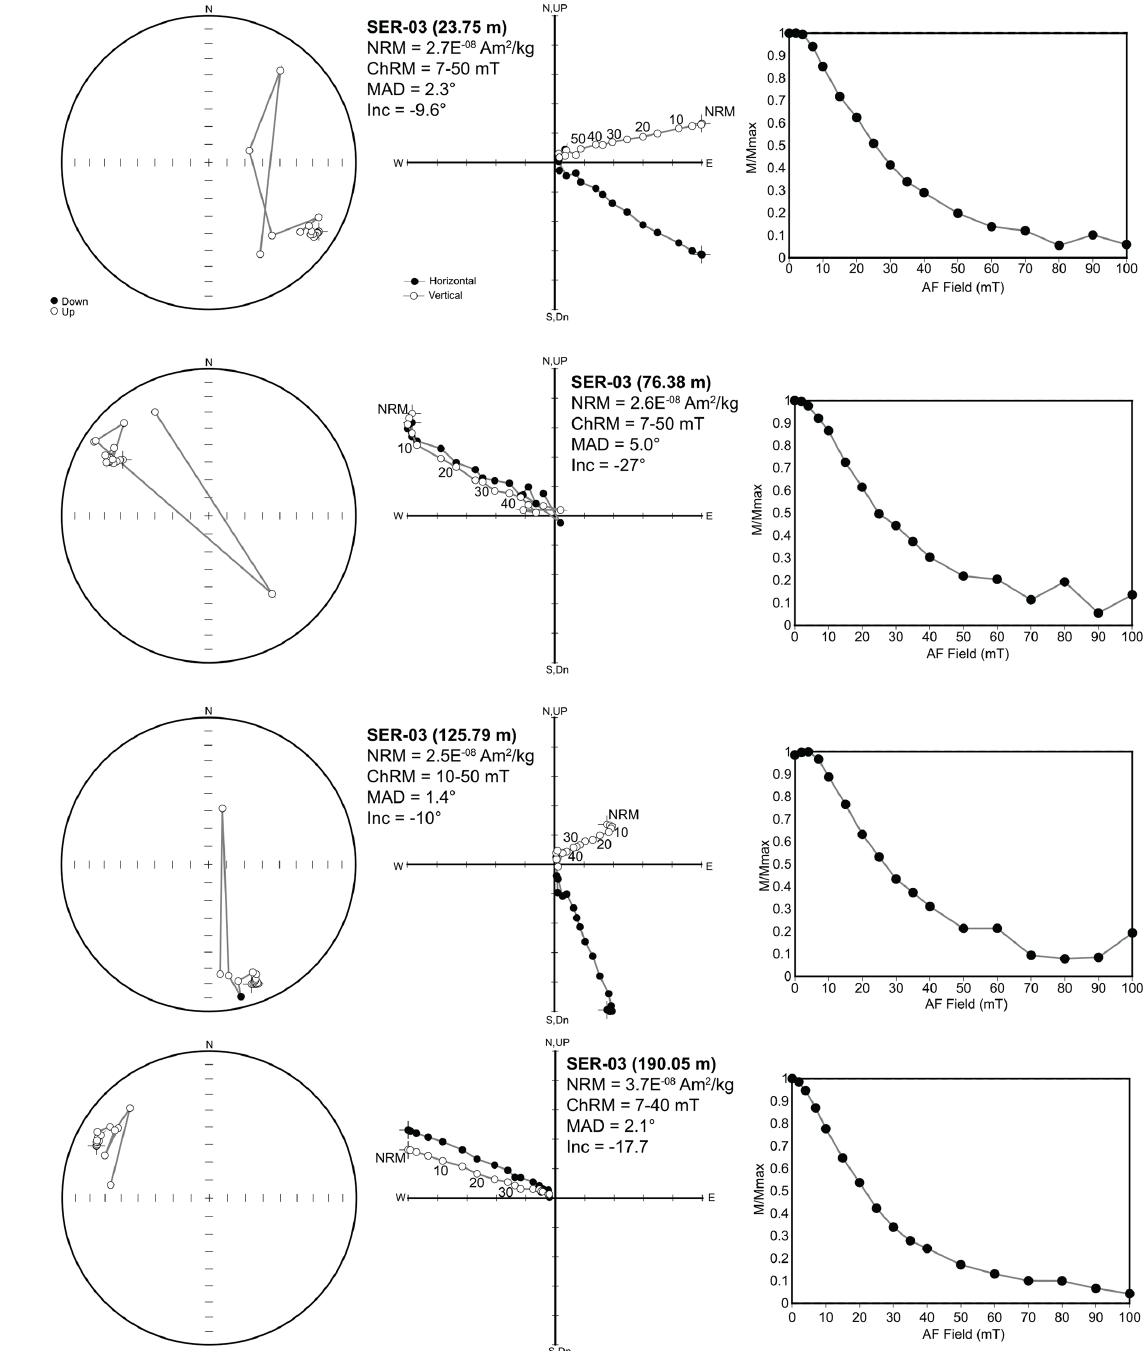
Figure 8. Typical alternating field (AF) demagnetization plots of four representative samples from the studied section. The down-core posi- tion of the samples is indicated by arrows in Fig. 7. Solid symbols indicate normal components; open symbols indicate reverse